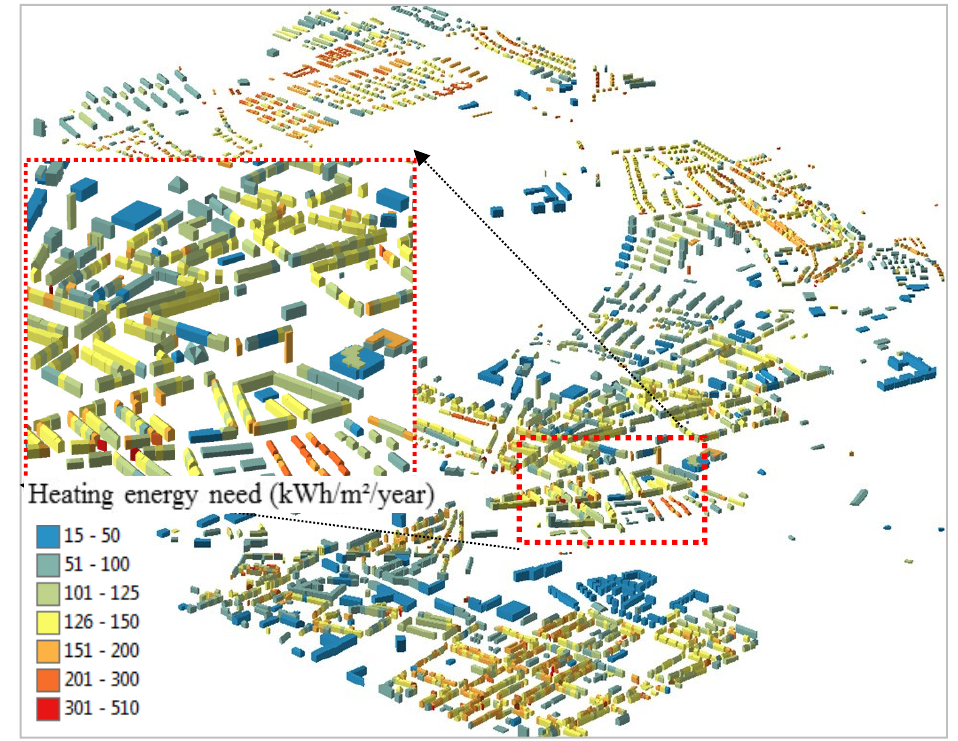
Figure 4. Illustration of annual heating energy need (kWh/m 2 ) in a district in the city of Karlsruhe in Germany.